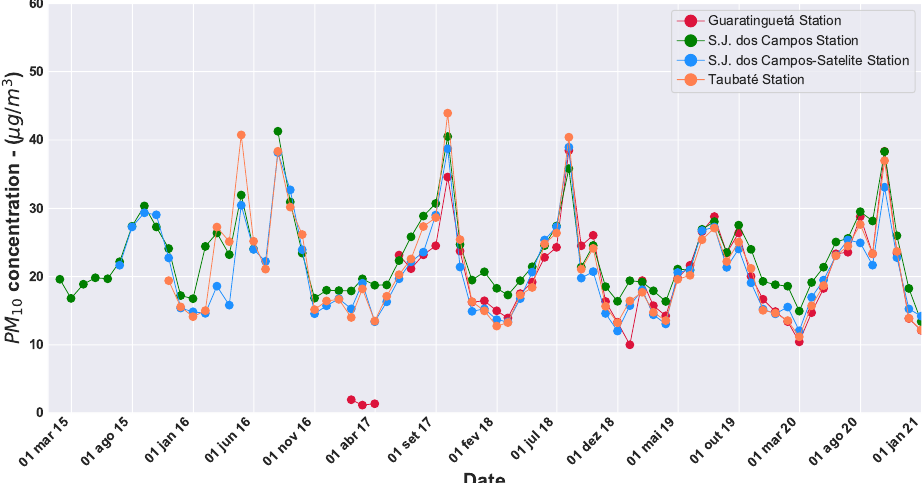
Figure 2. Time series distribution of the monthly mean particulate matter concentration for the period of March of 2015 to December of 2020 for all four CETESB air quality stations over Paraíba valley